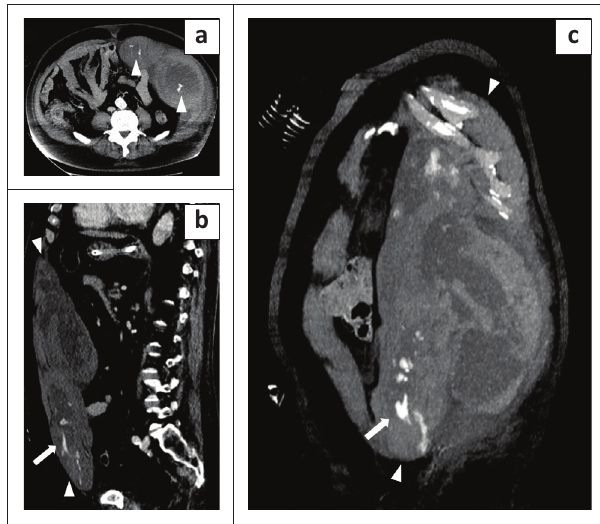
FIGURE 8: A 71-year-old man with a huge arterial feeder in an abdominal wall haematoma diagnosed 14 days after hospital admission. (a) Axial arterial phase, MIP reconstruction image demonstrates a bilobed-shaped left abdominal wall haematoma (arrow) with multiple foci of arterial blushes (arrowheads). (b) Arterial parasagittal and (c) coronal planes, MIP reconstruction images show the longitudinal extent of the haematoma (arrowheads) and the arterial blushes in its lower part (arrows). The patient, also developed pulmonary thrombo- embolism (not shown) and required endovascular embolisation twice, but later demised. TABLE 1: Imaging